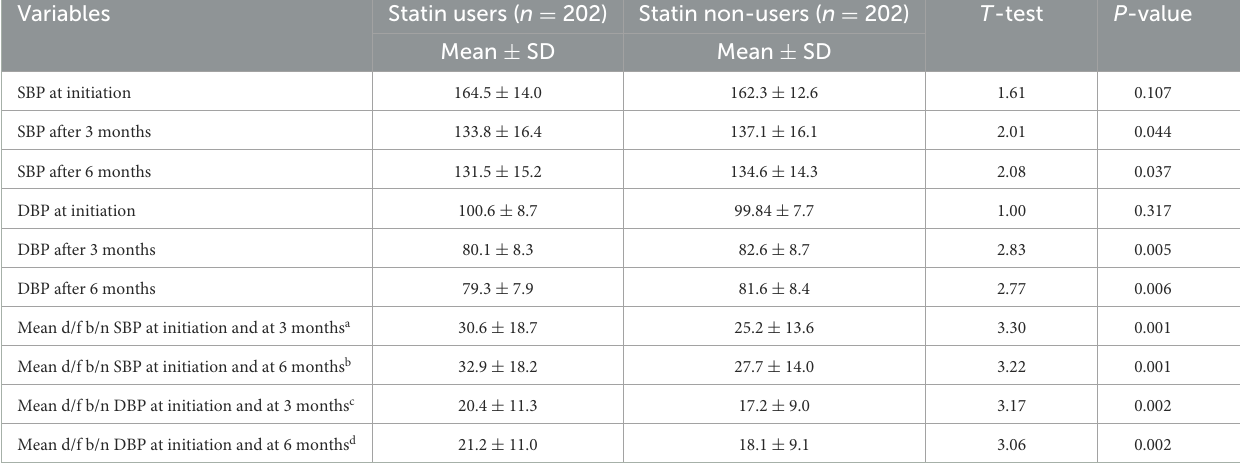
TABLE 6 T -test of difference in mean change of SBP and DBP of patients with hypertension attending the outpatient clinic at FHCSH, northwest Ethiopia.